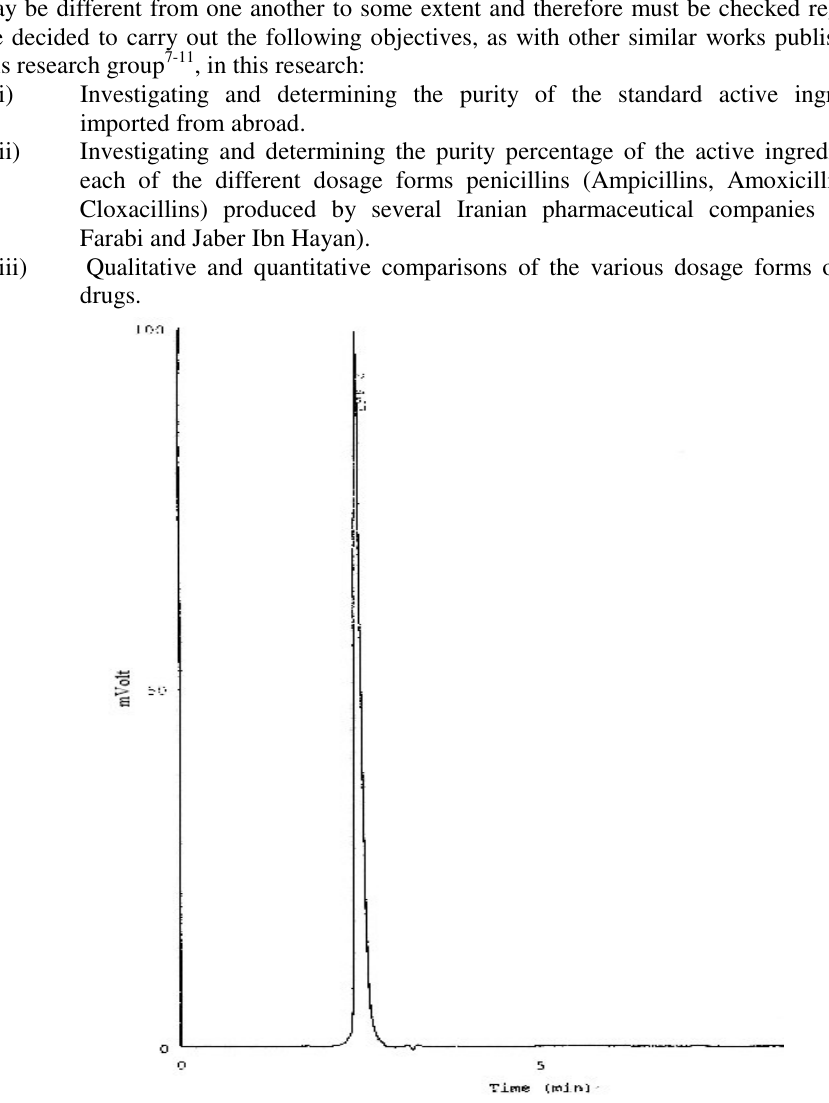
Figure 1 . HPLC Chromatogram and data peak report of ampicillin standard powder (active ingredient) imported from abroad.